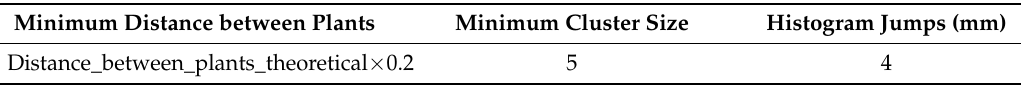
Table 5. Plant identification and stem identification